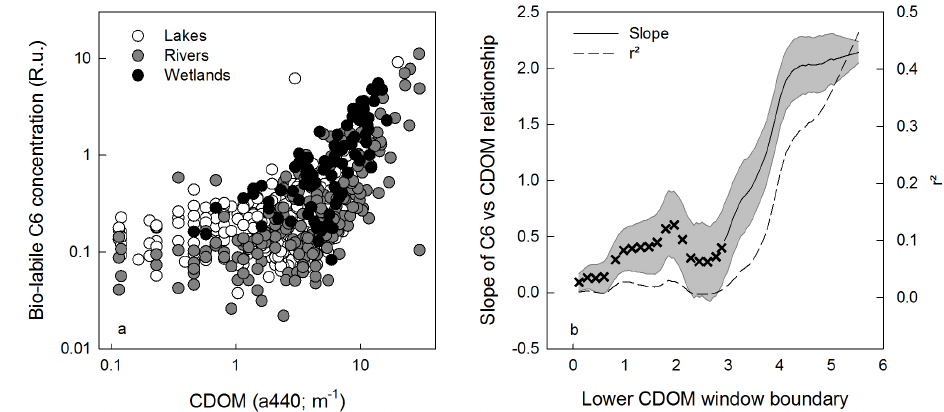
Figure 7. Concentrations of protein-like C6 as a function of CDOM in lakes, rivers and wetlands. (a) r 2 = 0 . 32, p < 0 . 001, n = 519. (b) Parameters of moving window regressions performed on discrete portions of the data set based on increasing CDOM. Total sample size was 519, but individual regressions were performed on subsets of 250 samples; a total of 270 regressions were thus performed. “x” signs denote nonsignificant regressions. x axis shows the lowest CDOM concentration included in the regression for which the parameters are reported. The first regression was thus performed on samples for which CDOM ranged from 0.12 to 3.11m − 1 , whereas the last regression was performed on samples for which CDOM ranged from 5.55 to 30.0m − 1 . Note that the slope characterizes the log(C6) vs. log(CDOM)